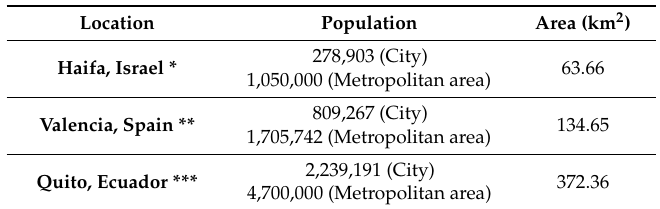
Table 2. Population and